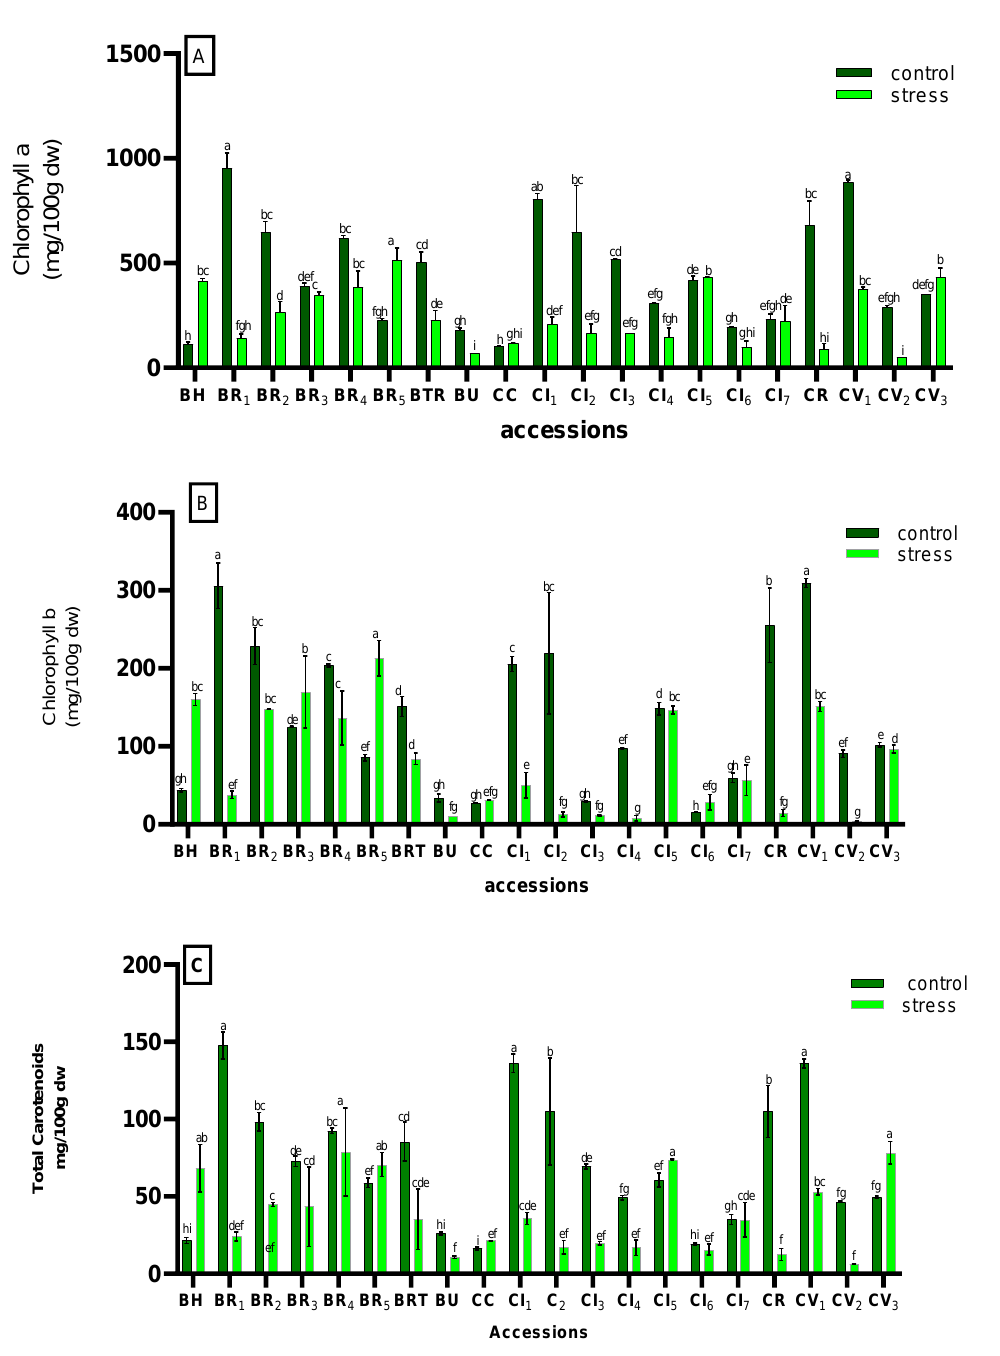
Figure 1. Variation on photosynthetic pigment content in the 20 Brassica oleracea accessions studied in relation to water stress treatment ( A ) chlorophyll a (Chla); ( B ) chlorophyll b (Chlb); (C ) total carotenoids (Caro); and Error bars indicate SE (n = 3). For each accession, different letters indicate significant differences between accessions subjected to the same treatment according to Tukey’s test (α = 0.05).